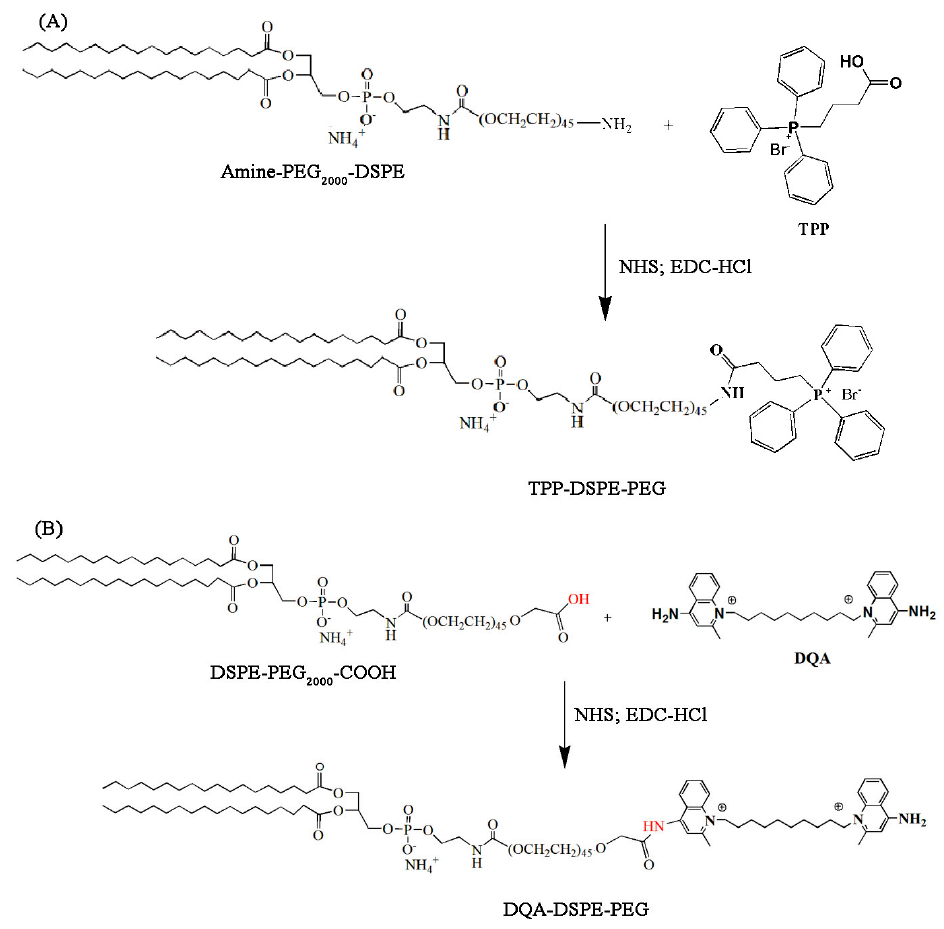
Figure 2. Synthesis scheme of TPP-DSPE-PEG ( A ) and DQA-DPPE-PEG ( B ) conjugate. DSPE-PEG 2000 -COOH, 1,2-distearoyl- sn -glycero-3-phosphoethanol-amine- N -[methoxy(polyethylene glycol)-2000-COOH] and DQA-DPPE-PEG, dequalinium-polyethylene glycol- distearoylphosphatidylethanolamine; TPP-DSPE-PEG, 4-carboxybutyl triphenylphosphonium bromide- polyethylene